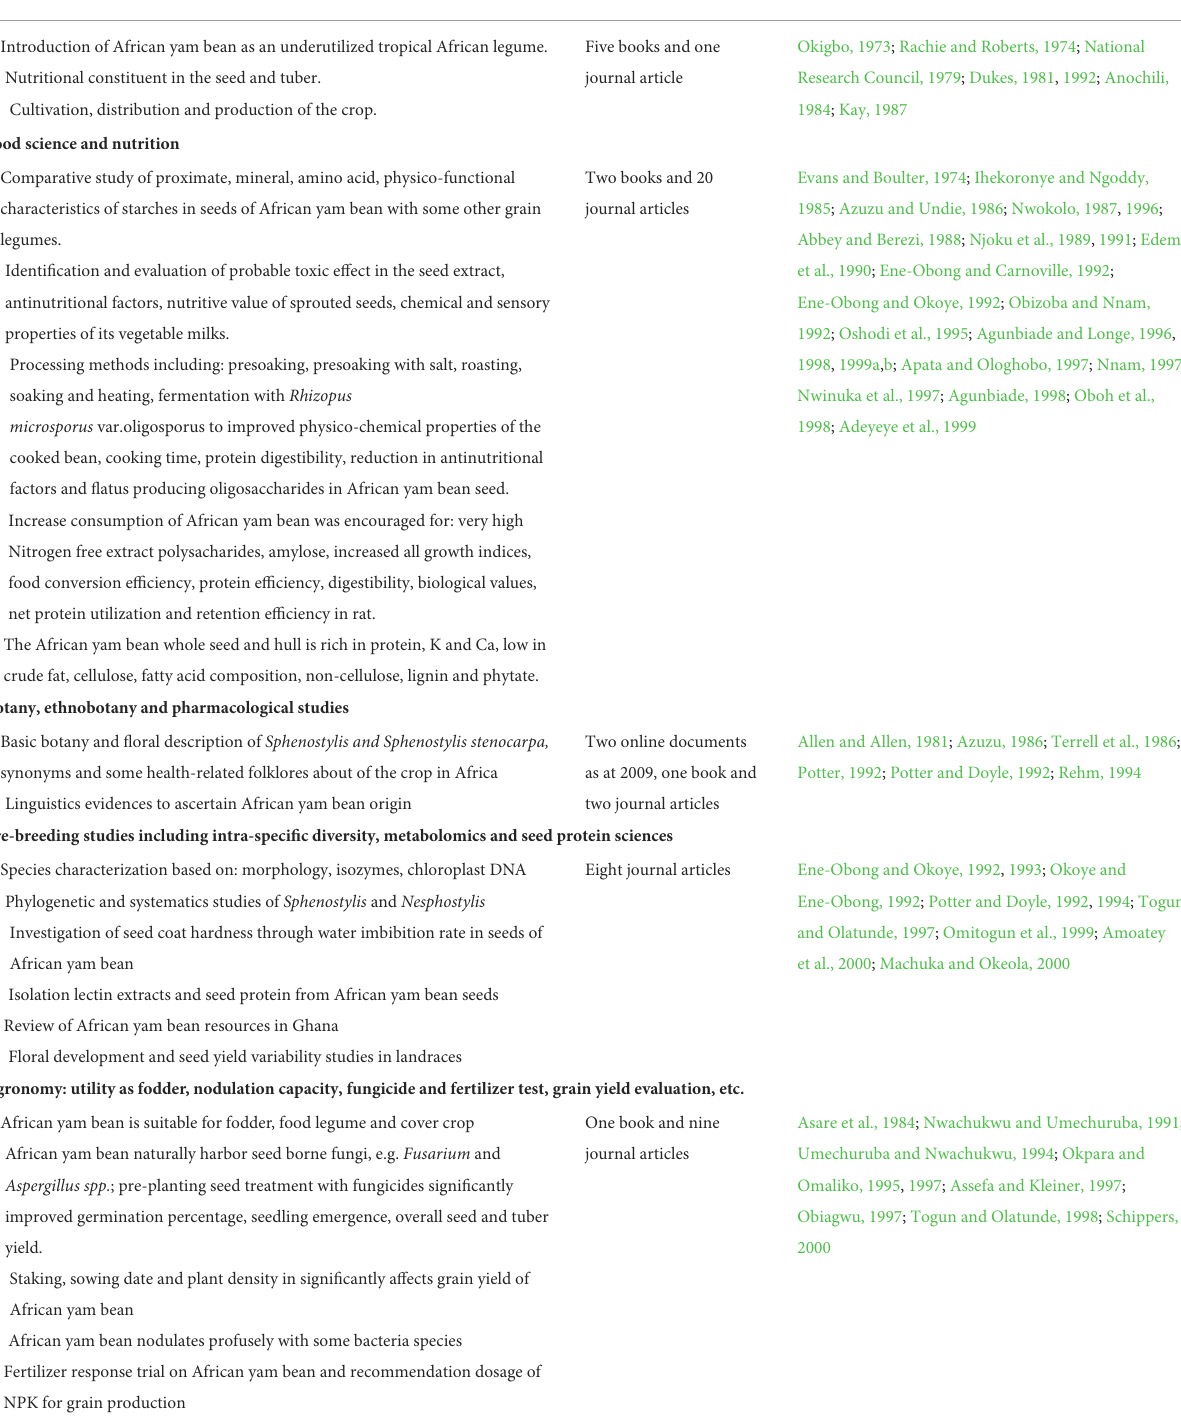
TABLE 1 African yam bean in literature within 1973 to 2000 with remarkable research features and outcomes. General